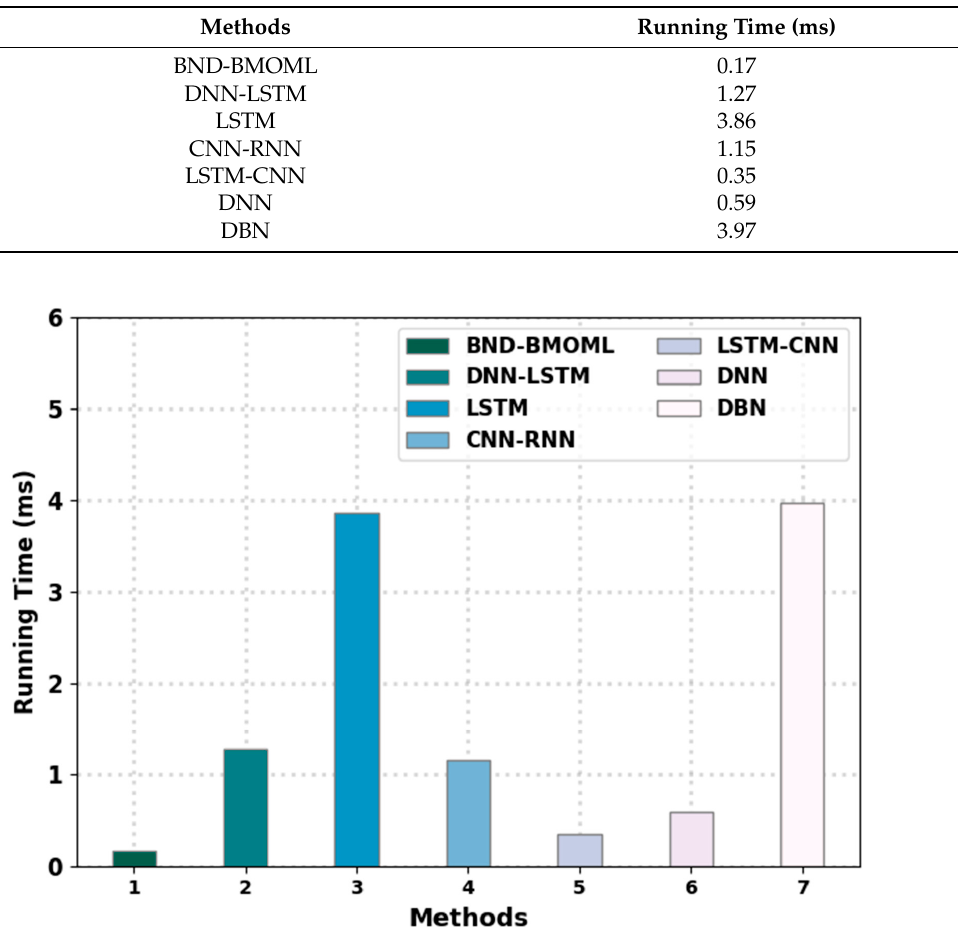
Figure 11. Running time analysis of BND-BMOML approach and recent algorithms.